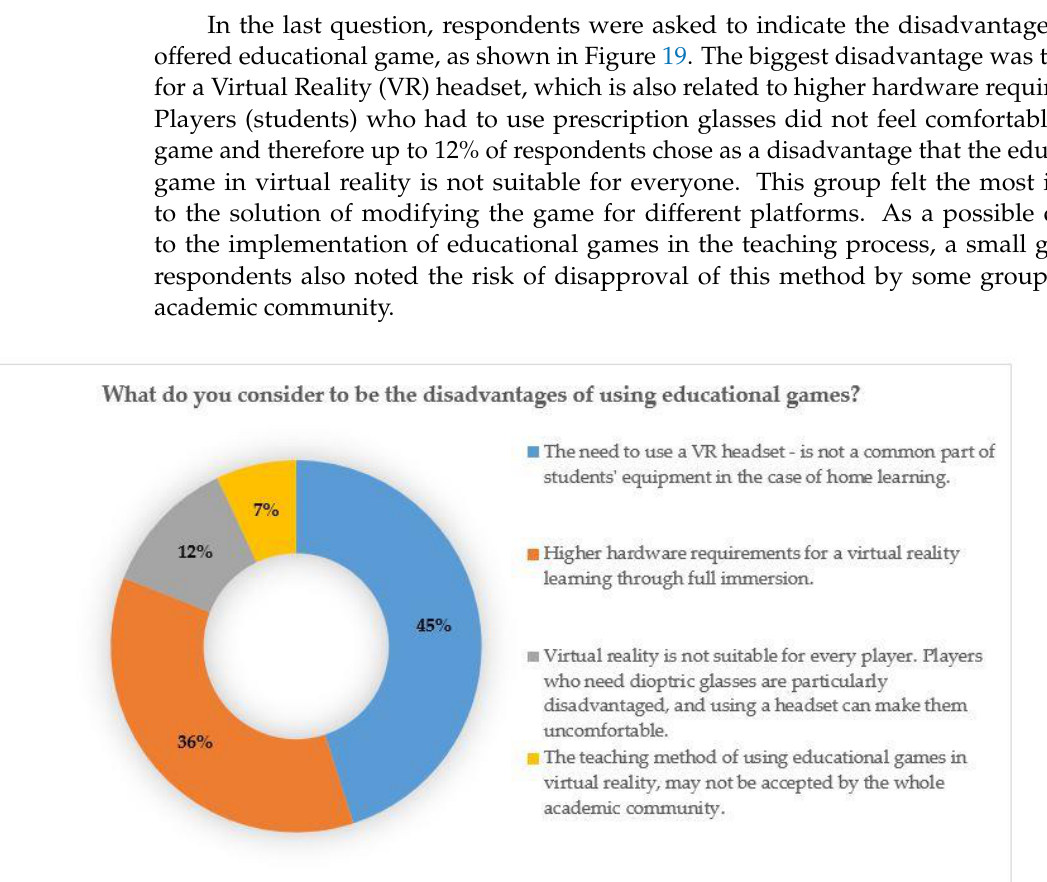
Figure 18. Subjective evaluation of the benefits of an educational game for students.